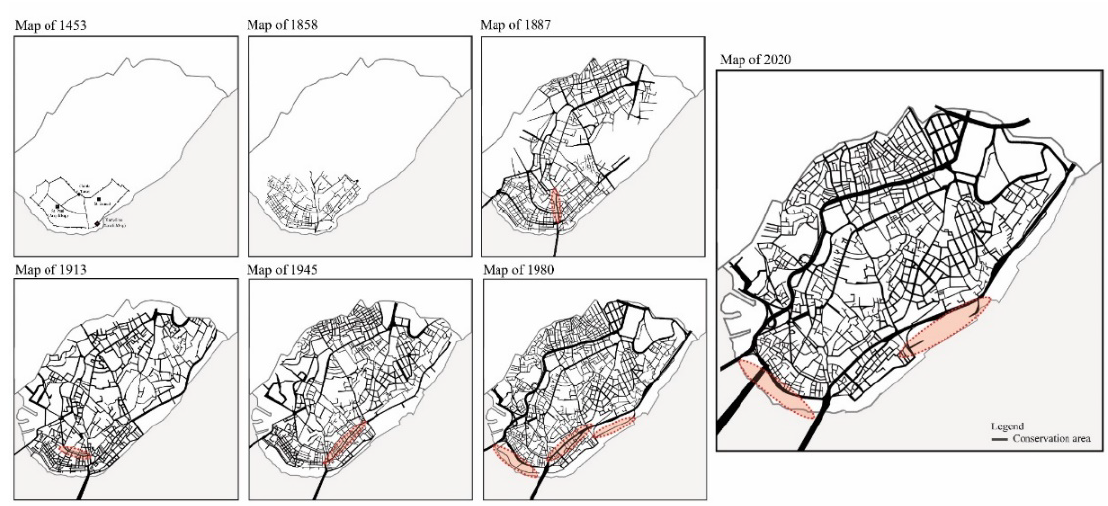
Figure 7 Development of the street pattern for examined periods studied, marked with important changes.